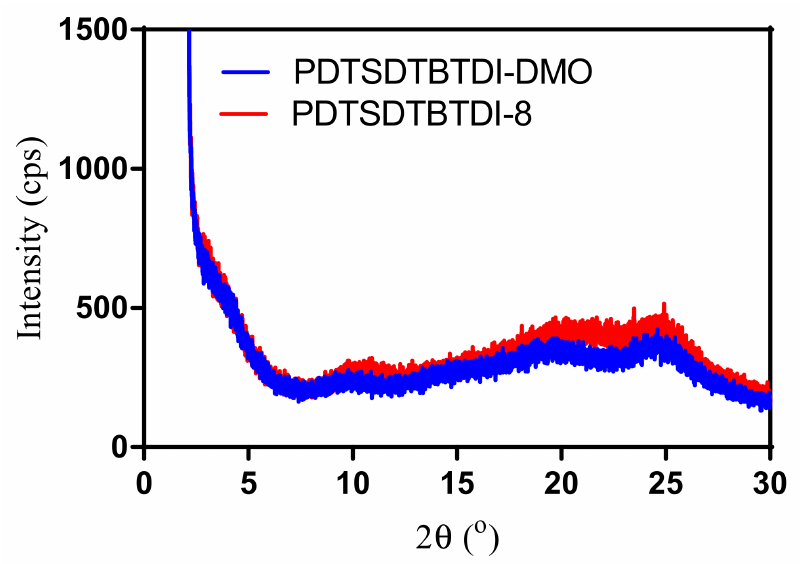
Figure 4. Powder XRD of PDTSDTBTDI-DMO and